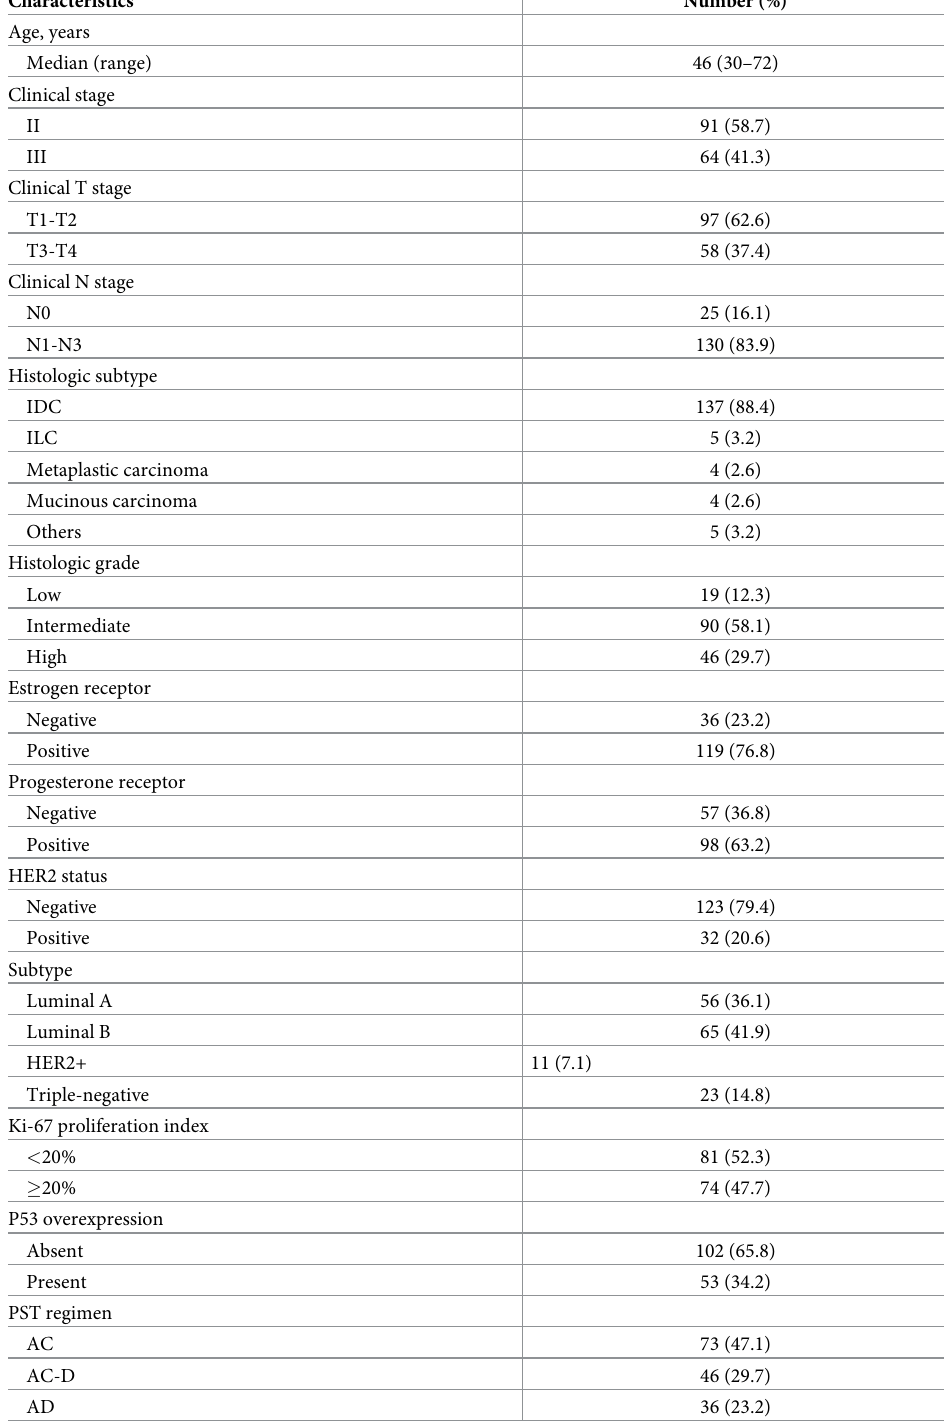
Table 1. Baseline characteristics of patients in pre-primary systemic therapy